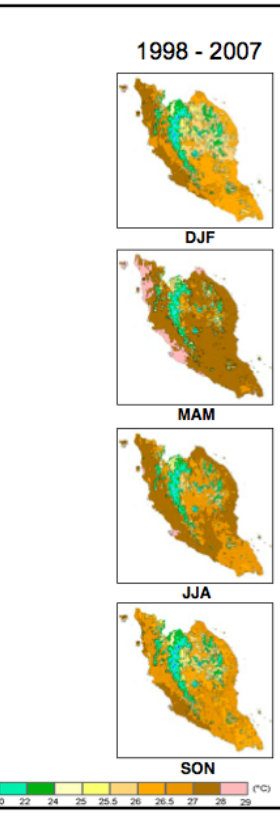
Figure 12. Long ‐ Term Mean Temperature for West Malaysia. Colours indicate the temperature in degrees Celsius. DJF ‐ December, January, February. MAM ‐ March, April, May. JJA ‐ June, July, August. SON ‐ September, October, November (Courtesy: Malaysia Meteorological